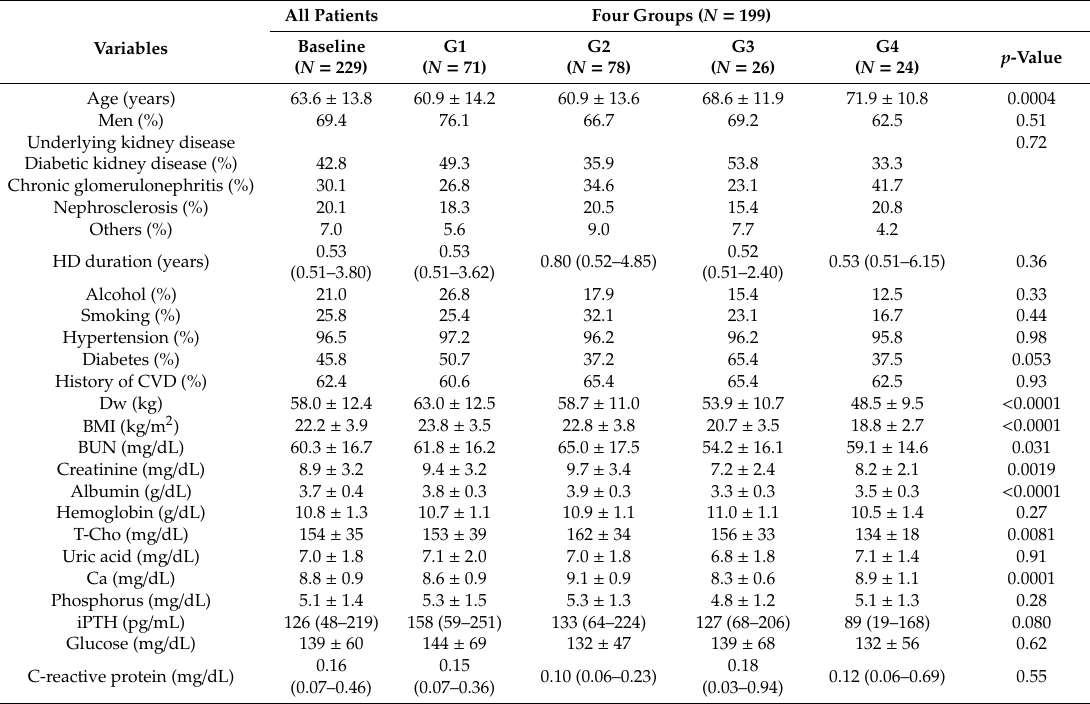
Table 1. Baseline characteristics of the study